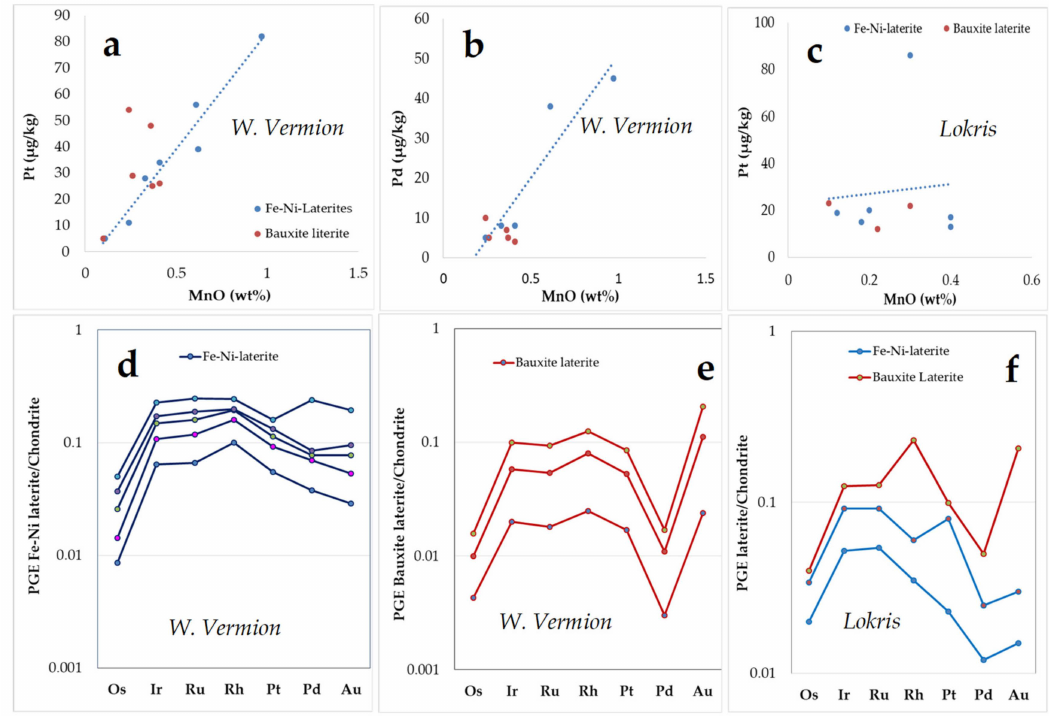
Figure 11. Plots of Pt and Pd versus MnO ( a – c ) and chondrite normalized PGE patterns for Fe–Ni laterites and bauxite from W. Vermion and Lokris ( d – f ). Data from Tables